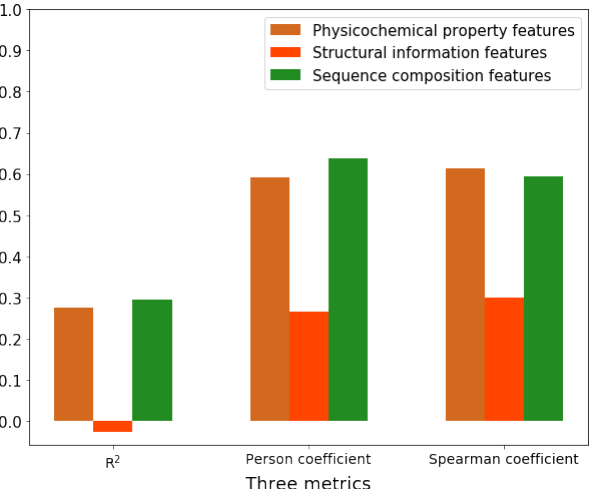
Figure 4. Three performance measures ( R 2 , Pearson’s correlation coefficient, and Spearman’s correlation coefficient) produced by 6 physicochemical features, 17 structural information features, and 70 sequence composition features based on the PLSR model when the number of component is